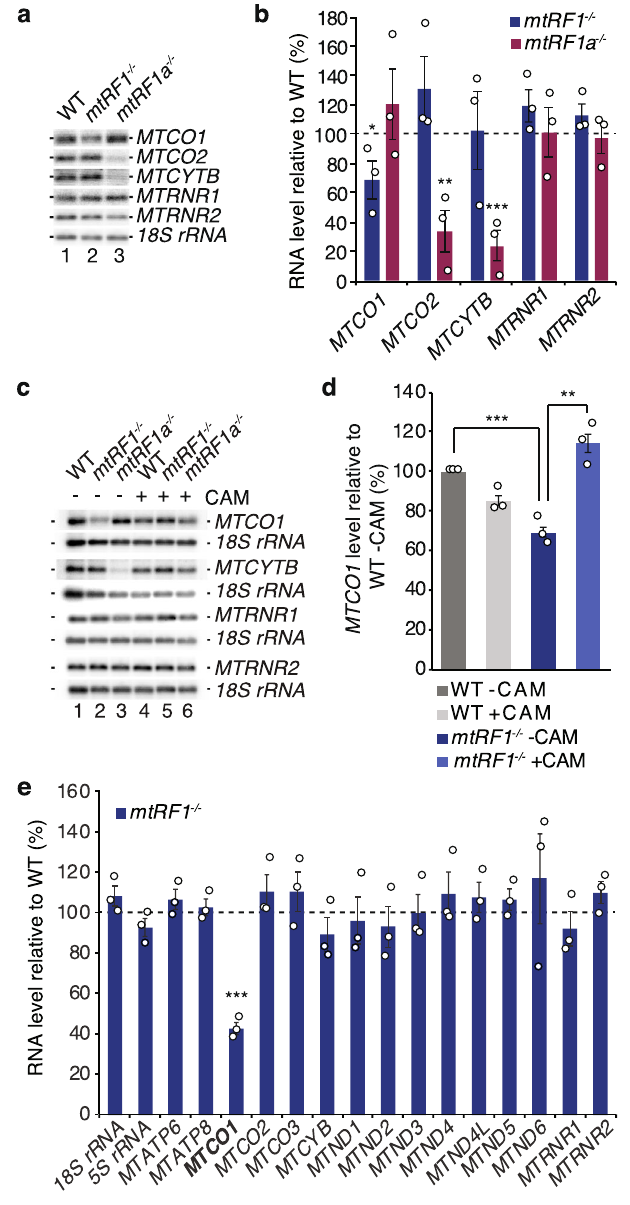
Fig. 4 | Mitochondrial transcripts are altered upon ablation of mtRF1 or mtRF1a. a , b RNA was isolated from wild-type (WT) cells, mtRF1 − / − and mtRF1a − / − and subjectedto northernblot analysis. Mitochondrial mRNAs encoding for COX1 ( MTCO1 ), COX2 ( MTCO2 ) and CYTB ( MTCYTB ) as well as the mt-rRNAs 12S rRNA ( MTRNR1 ) and 16S rRNA ( MTRNR2 )weredetectedusing speci fi cprobes.18SrRNA was usedasloading control.RNA levels are calculatedrelative to WT (dashed line) and individual data points are indicated as circles. Statistical analysis was per- formed as two-sample one-tailed Student ’ s t -test with n =3 biologically indepen- dent samples and shown as mean±SEM. Signi fi cance was de fi ned as * p ≤ 0.05 ; ** p ≤ 0.01 ; *** p ≤ 0.001. c , d RNA was isolated from WT, mtRF1 − / − and mtRF1a − / − and statistical analysis were performed as in a , b . e Isolated RNA from WT and mtRF1 − / − mitochondria was subjected to NanoString analysis. 18S and 5S rRNA were used as controls. The relative RNA levels of WT are indicated as dashed line. Statistical analysis was performed as two-sample one-tailed Student ’ s t -test